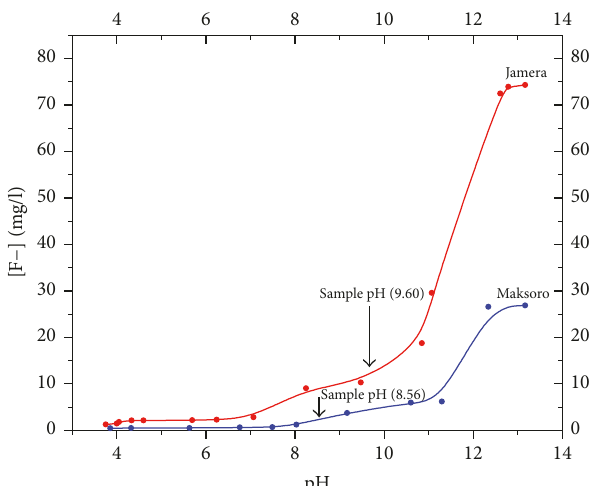
Figure 8: pH dependent fluoride leaching in feldspar-quartz igneous rock at 25 ∘